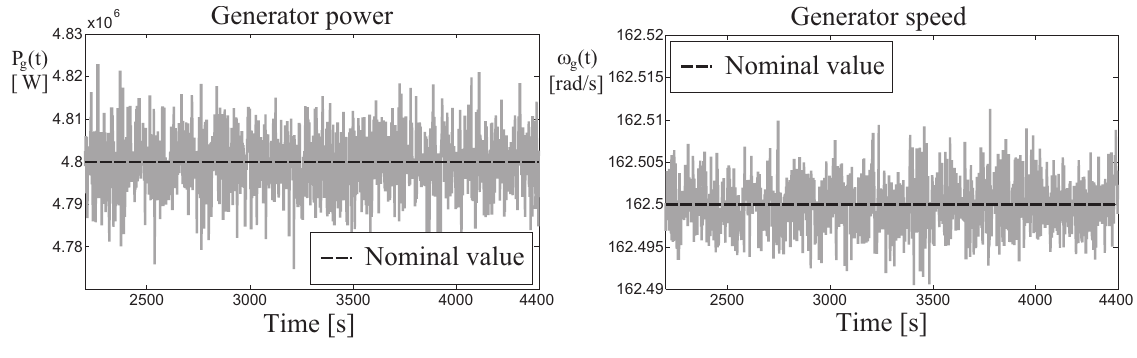
Figure 11. Simulations in full load with the adaptive